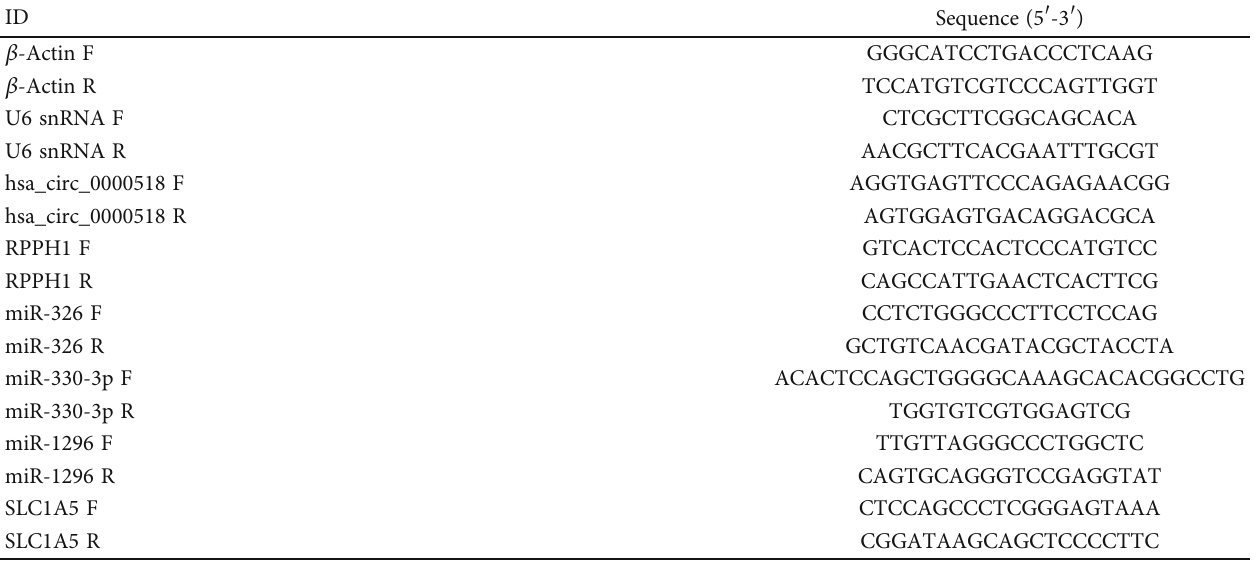
Table 2: Primer sequences used for qRT-PCR.